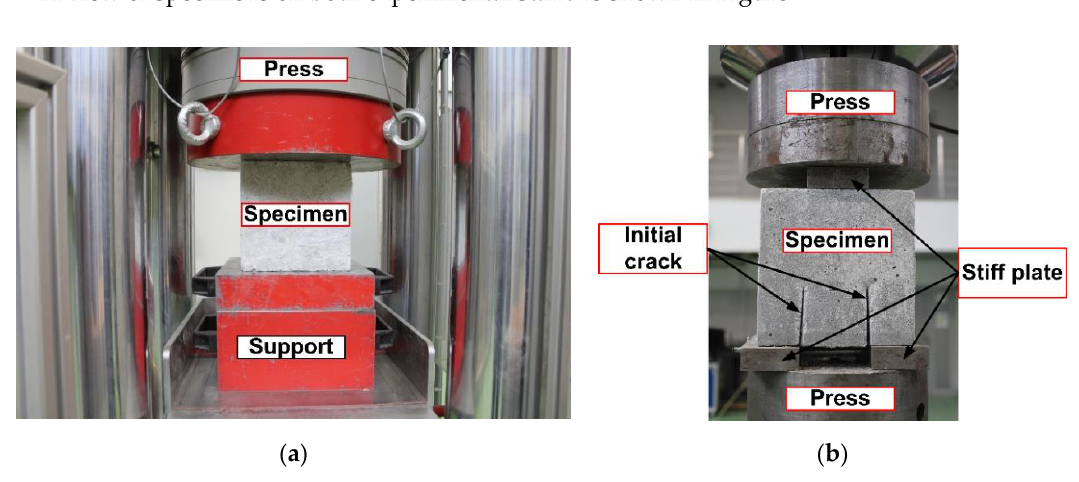
Figure 7. Specimens during the tests: ( a ) compressive strength; ( b ) fracture toughness.